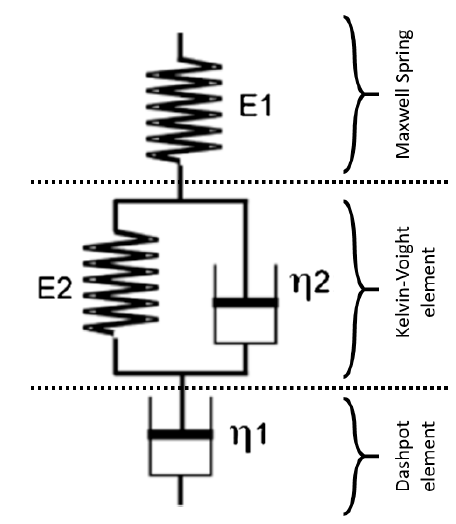
Figure 8. Schematic diagram of Burger model.